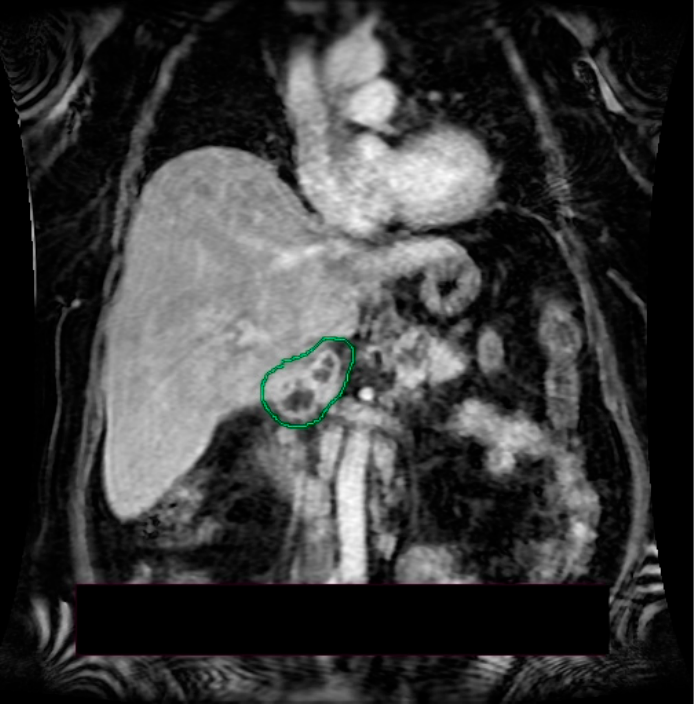
Figure 3. MRI − T1 post contrast sequence, coronal imaging plane: inhomogeneous cephalopancre- atic lesion.